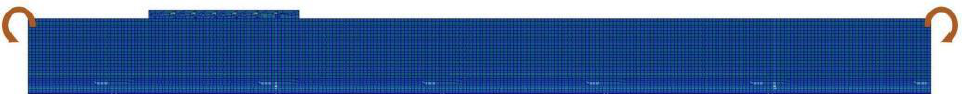
Figure 14. Schematic diagram of finite element model with multipoint constraints. Figure 15. Schematic diagram of bending moment Figure 15. Schematic diagram of bending moment loading. Figure 15. Schematic diagram of bending moment loading.